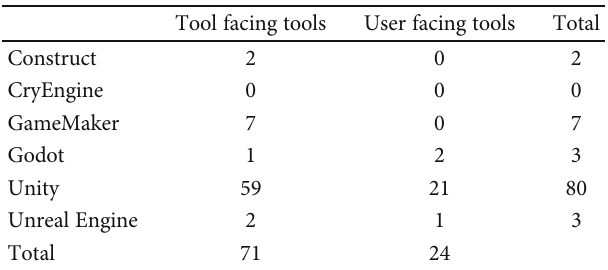
Table 4: Summary of types of tools in the o ffi cial tool libraries per game